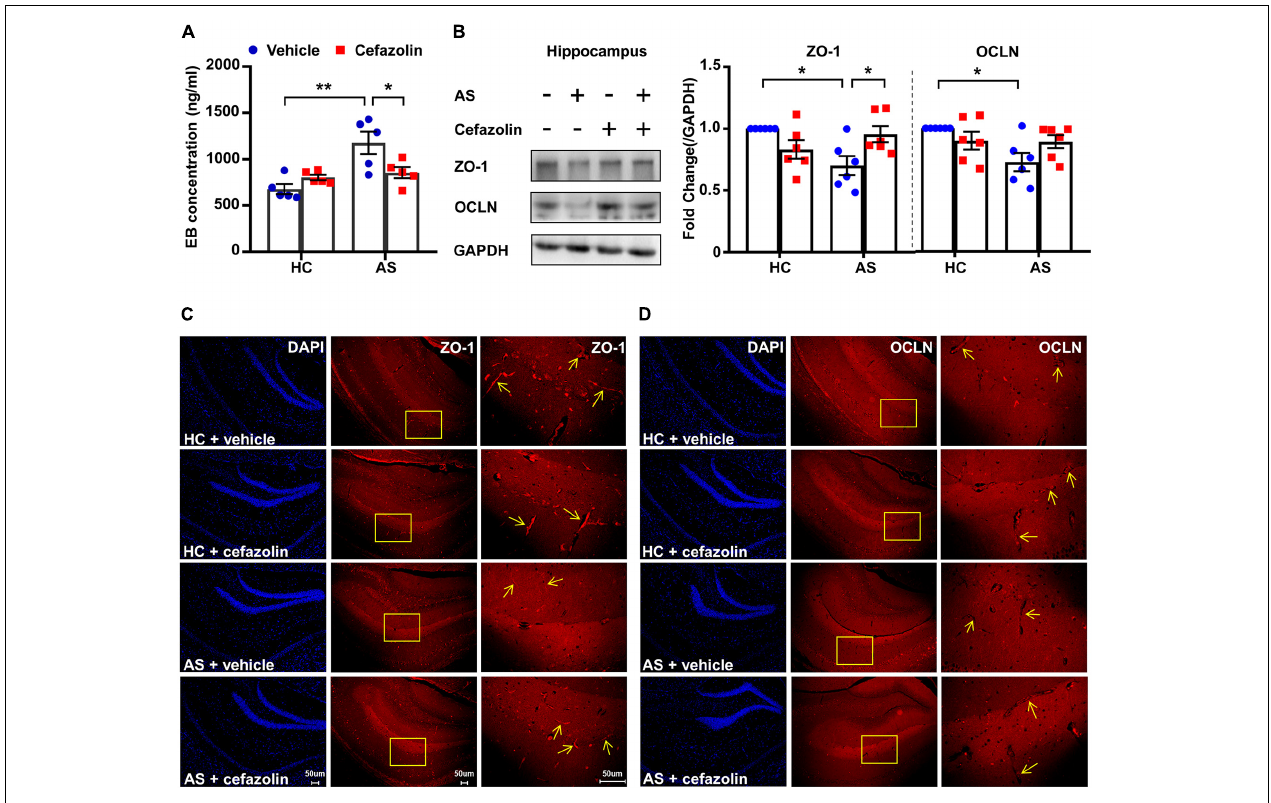
FIGURE 3 | Perioperative use of cefazolin reversed the alterations of BBB permeability and tight junction proteins in the AS group. (A) Hippocampal EB concentration of mice in the four groups. (B) Representative bands and quantitation of ZO-1 and OCLN proteins in the hippocampi (relative to GAPDH). (C) Representative images of DAPI and ZO-1 in the hippocampus for immunofluorescence. (D) Representative images of DAPI and OCLN in the hippocampus for immunofluorescence. Data are shown as mean ± S.E.M. (for EB test, n = 5 in each group; for western blot and immunofluorescence, n = 6 in each group). * P < 0.05 or ** P < 0.01. AS, anesthesia and surgery; EB, Evans blue; GAPDH, glyceraldehyde phosphate dehydrogenase; HC, healthy control; NCD, non-POCD; N.S., not significant; OCLN, occludin; POCD, post-operative cognitive dysfunction; ZO-1, zonula occludens